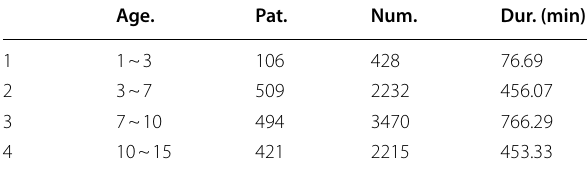
Table 1 The data distribution of typical absence